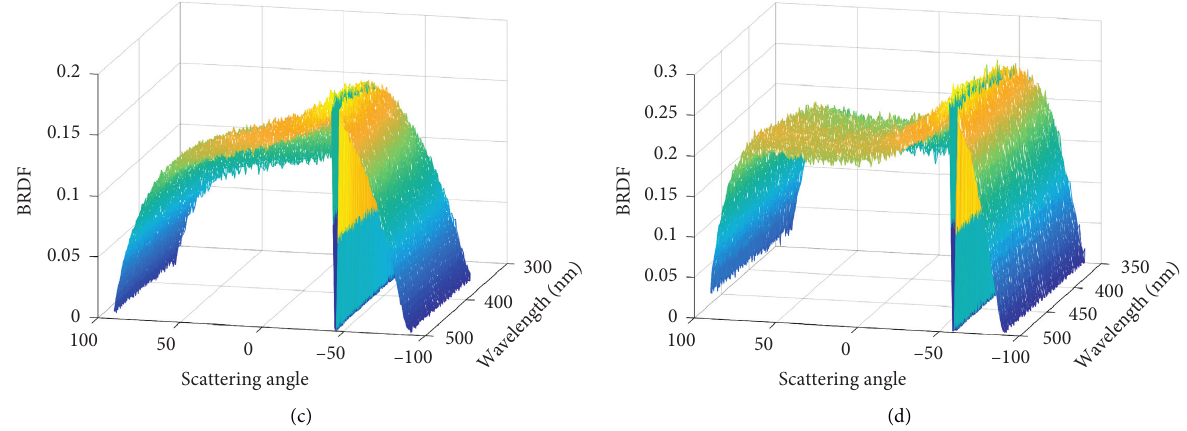
Figure 8: 3D graph of sample 5. (a) 3D data of 0 ° incident angle; (b) 3D data of 30 ° incident angle; (c) 3D data of 45 ° incident angle; (d) 3D data of 60 ° incident